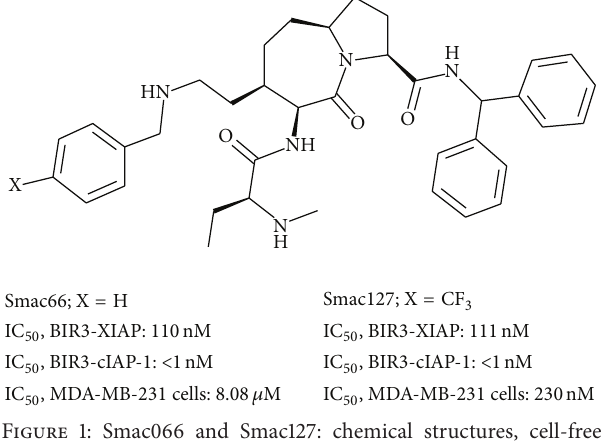
Figure 1: Smac066 and Smac127: chemical structures, cell-free affinity for IAPs, and cytotoxicity against MDA-MB-231